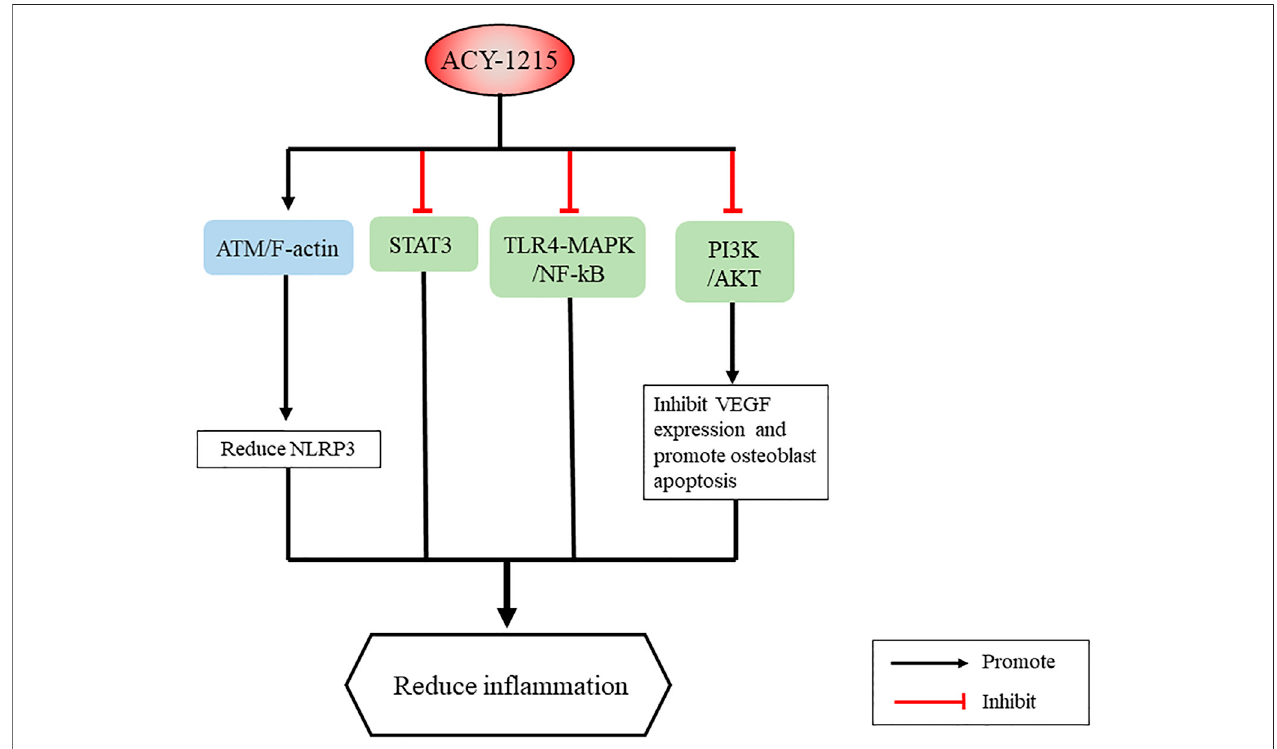
FIGURE 6 | Signaling pathways and proteins in in fl ammation regulated by